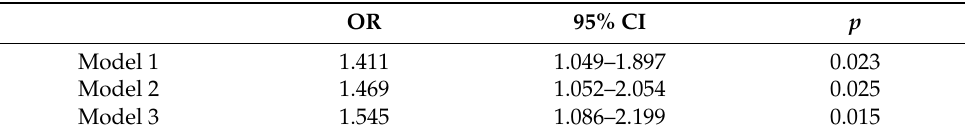
Table 3. Independent effect of RANKL (per SD) on